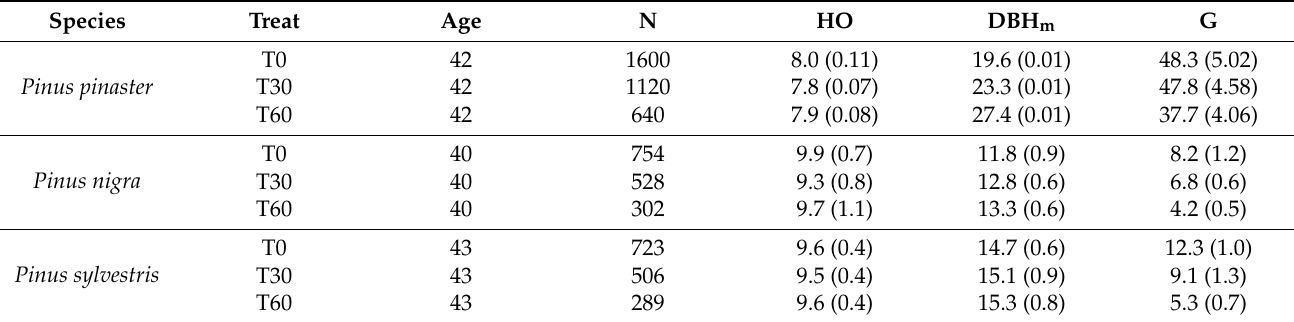
Table 1. Characterisation of the Pinus spp. of dasometric variables per treatment plot at Sª de Los Filabres (Almer í a, Spain). Treat: thinning intensities of stem density removed—T0 (0%), T30 (30%) and T60 (60%); Age: years of the plantation; N: stand density (stems ha − 1 ); HO: dominant height (m); DBHm: mean diameter at breast height (cm); G: basal area (m 2 ha − 1 ). Values are the means ± standard error (in